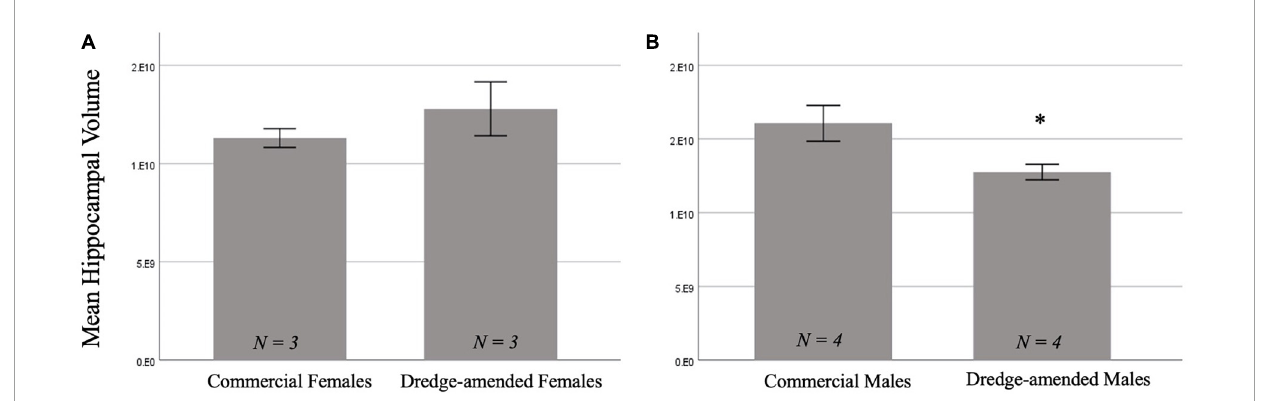
FIGURE3 Early exposure to dredge-amended corn affects adult hippocampal volume. Mean hippocampal volume measurements for commercial and dredge-amended females [ (A) ; N = 6] and males [ (B) ; N = 8] with standard error bars. Dredge-amended males had a decrease (indicated by ∗ ) in hippocampal volume compared to their commercial counterparts. There was no significant effect of corn treatment in